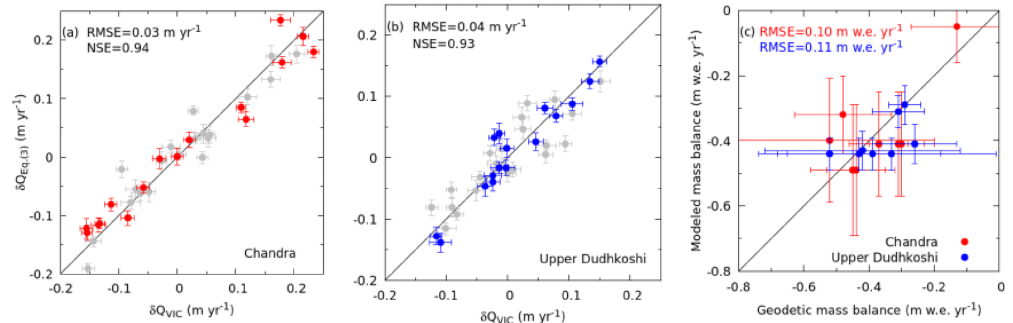
Figure 6. The summer runoff anomalies δQ Eq . ( 3 ) as computed using the Eq. (3) are compared with those from the VIC model simula- tions δQ VIC for (a) Chandra and (b) upper Dudhkoshi catchments. The solid red (blue) circles are for the Chandra (upper Dudhkoshi) catchment during the validation period 1980–1996. The solid grey circles denote data from the calibration period 1997–2018. (c) A com- parison of the modelled glacier mass balance with the available regional-scale geodetic mass balance for the Chandra (solid red circles) and upper Dudhkoshi (solid blue circles) catchments. The modelled values are over the same period as that of the corresponding observed geodetic mass balance (Table S3). The solid grey line in each plot shows the 1 : 1 reference